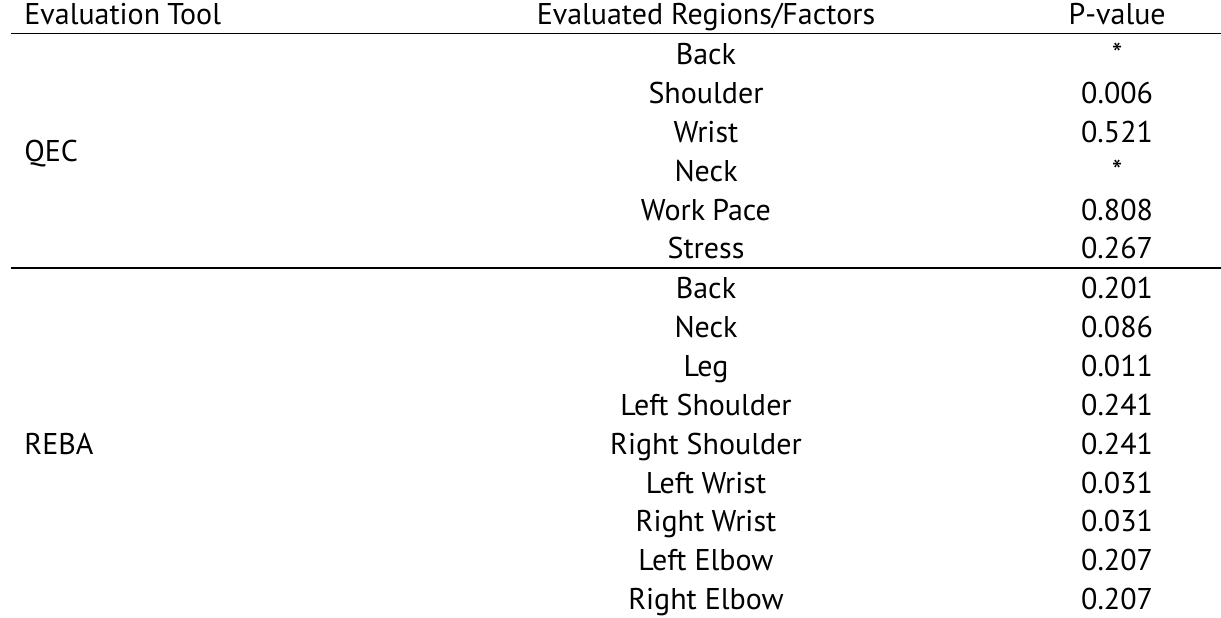
ANOVA of QEC and REBA evaluation between operations in small-scale feed mills Evaluation Tool Evaluated